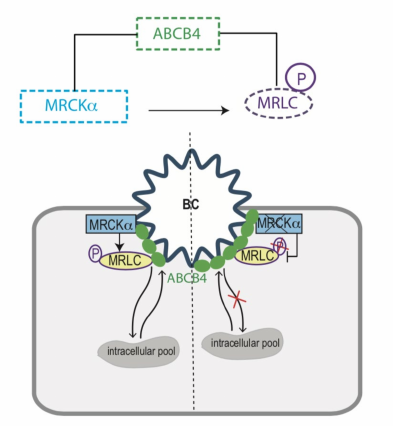
Figure 7. A model for ABCB4 canalicular membrane expression regulation. In the presence of MRCK α and phosphorylated MRLC, ABCB4 is internalized from the canalicular membrane. In MRCK α knockout cells, MRLC is not phosphorylated, resulting in an accumulation of ABCB4 at the canalicular